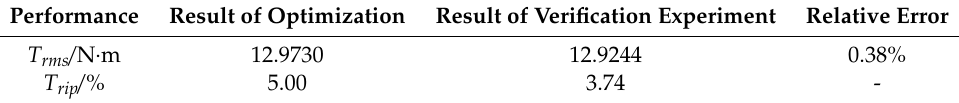
Table 5. The effect of parameter optimization.